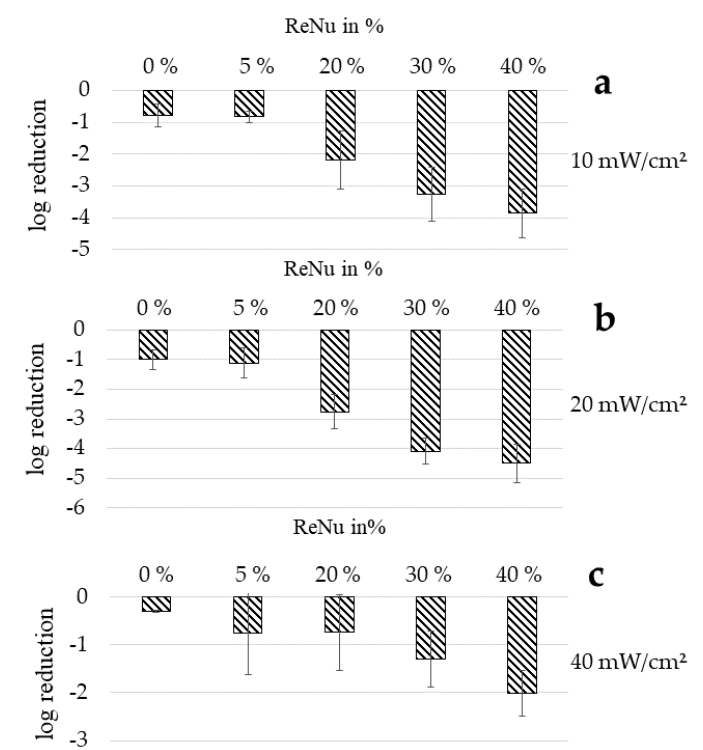
Figure 3. Log reduction results for combinations of di ff erent concentrations of ReNu Multiplus with visible light of 405 nm on agar plates. A dose of 140 J / cm 2 was reached with 10 mW / cm 2 in 4 h ( a ), 20 mW / cm 2 in 2 h ( b ), 40 mW / cm 2 in 1 h ( c ). Error bars indicate the deviation in the three experiments. Comparing di ff erent irradiation intensities reaching the same dose of 140 J / cm 2 over various exposure times it becomes evident that the highest irradiation intensity is not necessarily the best choice. At 40 mW / cm 2 for 1 h (140 J / cm 2 ) the lowest reduction results are achieved with only a 2.01 log decrease at 40% ReNu Multiplus in combination with 405 nm irradiation. Best combination results were achieved at 20 mW / cm 2 and 40% concentration of ReNu Multiplus with 4.49 log